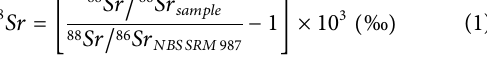
Frontiers in Earth Science |